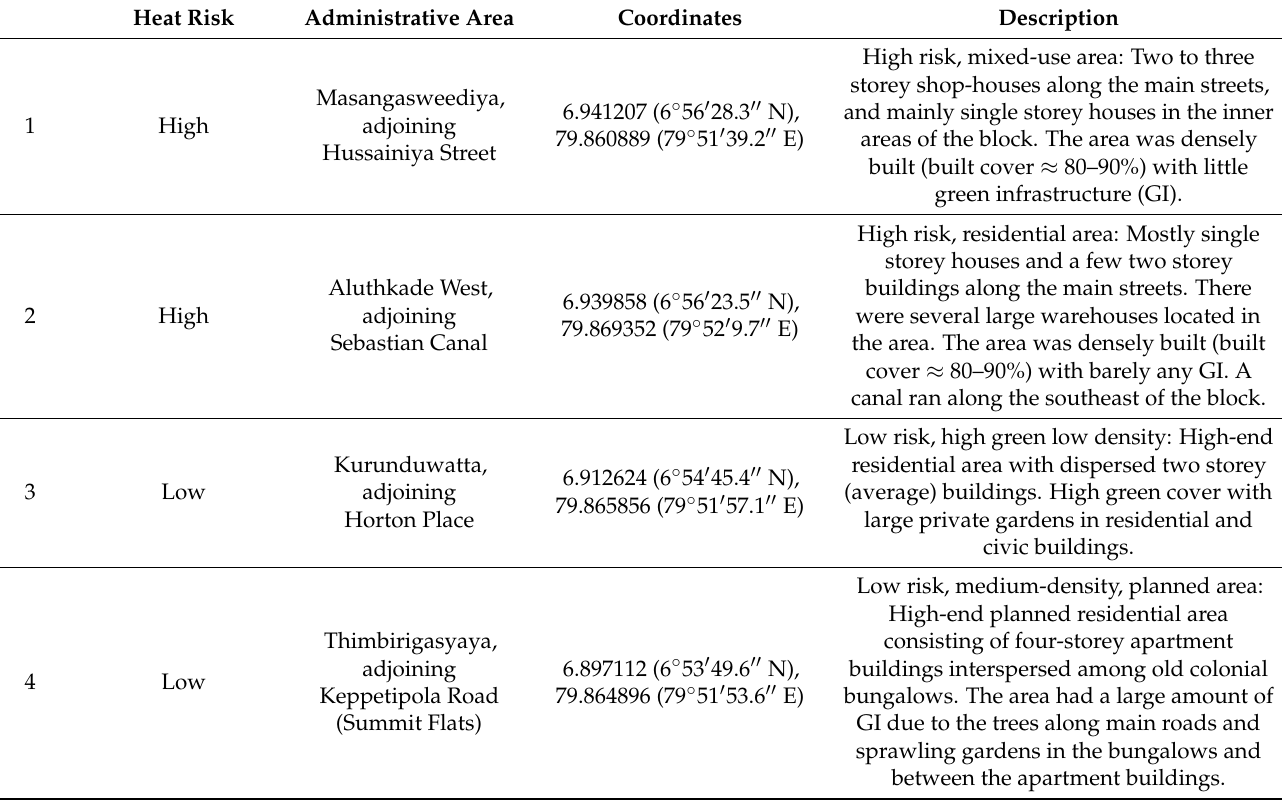
Table 11. Selected locations for heat risk estimation legend and descriptions.